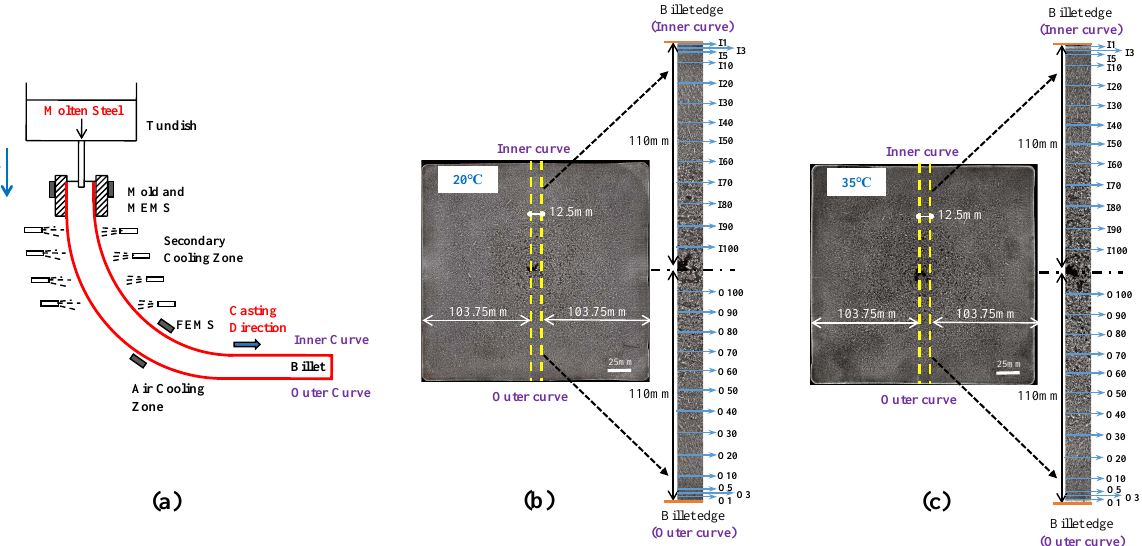
Figure 1. Macrostructure of bearing steel from CC billet subjected to different casting superheats. The size of the billet is 220 mm × 220 mm. ( a ) Schematic diagram of continuous casting process. The superheat is the difference between the molten steel temperature and liquidus temperature in the tundish. MEMS and FEMS mean mold electromagnetic stirring and final electromagnetic stirring, respectively. The only difference between two billets ( b ) and ( c ) is the superheat. One is 20 ◦ C and the other is 35 ◦ C. The hot pickling experiment for billet etched surface (macrostructure) of transverse section is carried out with 50% hydrochloric acid–water. The blue line with arrow denotes the scanning location with its direction for measuring the etched surface height. The scanning